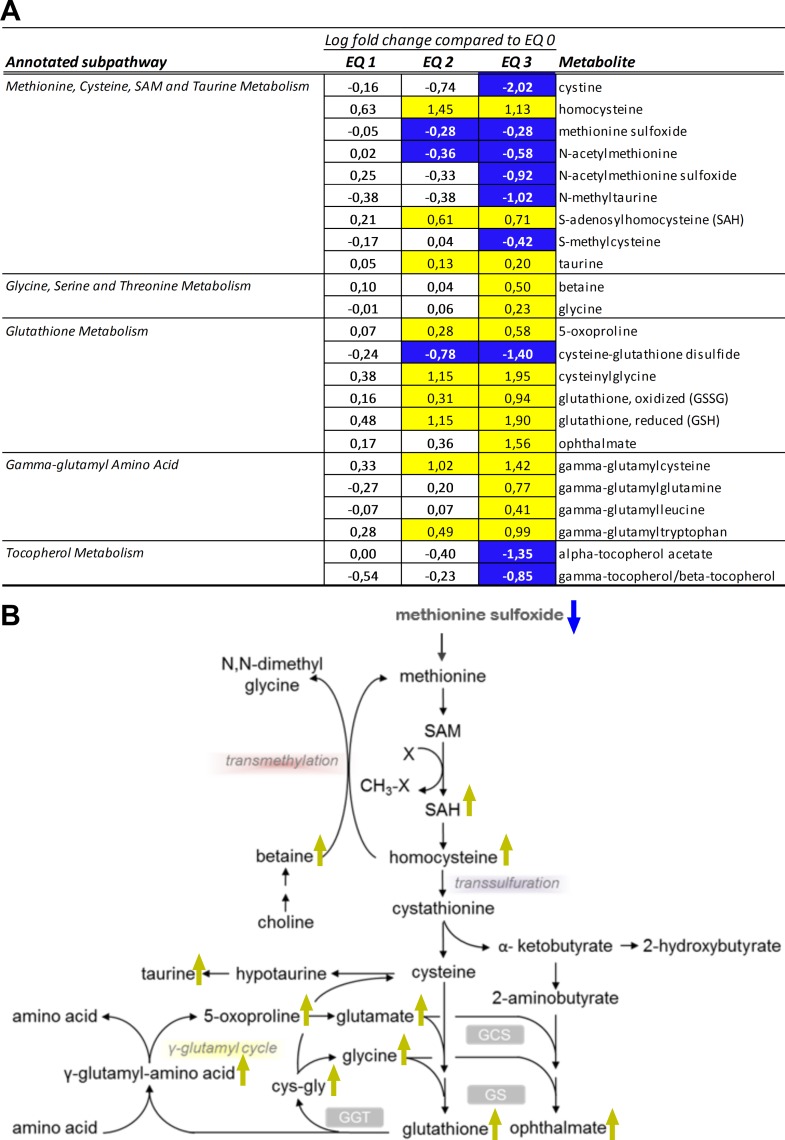
Changes in redox homeostasis in livers of Atlantic salmon (Salmo salar L.) exposed to graded levels of ethoxyquin (EQ) through their diet for 90 days.(A) Metabolites displaying differential expression (p<0.05, ANOVA) were grouped according to subpathway annotations. Scaled intensity means were used to calculate log2 fold changes in the individual exposure groups compared to unexposed control animals (EQ 0). Significance of change was analyzed through pairwise comparisons between the individual exposure groups and the control, with colors denoting a significantly (p<0.05) increased (yellow) or decreased (blue) levels compared to the control. (B) Overview of selected treatment affected metabolites within the cysteine and glutathione metabolic pathways. Metabolites significantly (p<0.05) affected by the increasing EQ levels are denoted with yellow (increase) or blue (decrease) arrows. See S4 Table for a complete overview of individual metabolites.